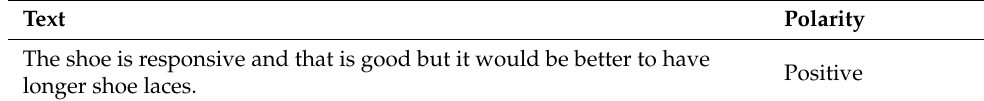
Table 3. Example sentence extracted from social media with no punctuation. Text